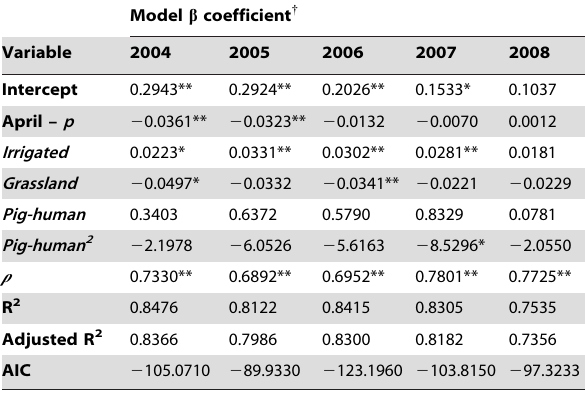
Table 4. Comparison of parsimonious 2004 to 2008 models of district-level JE incidence as a function of climate, agriculture and